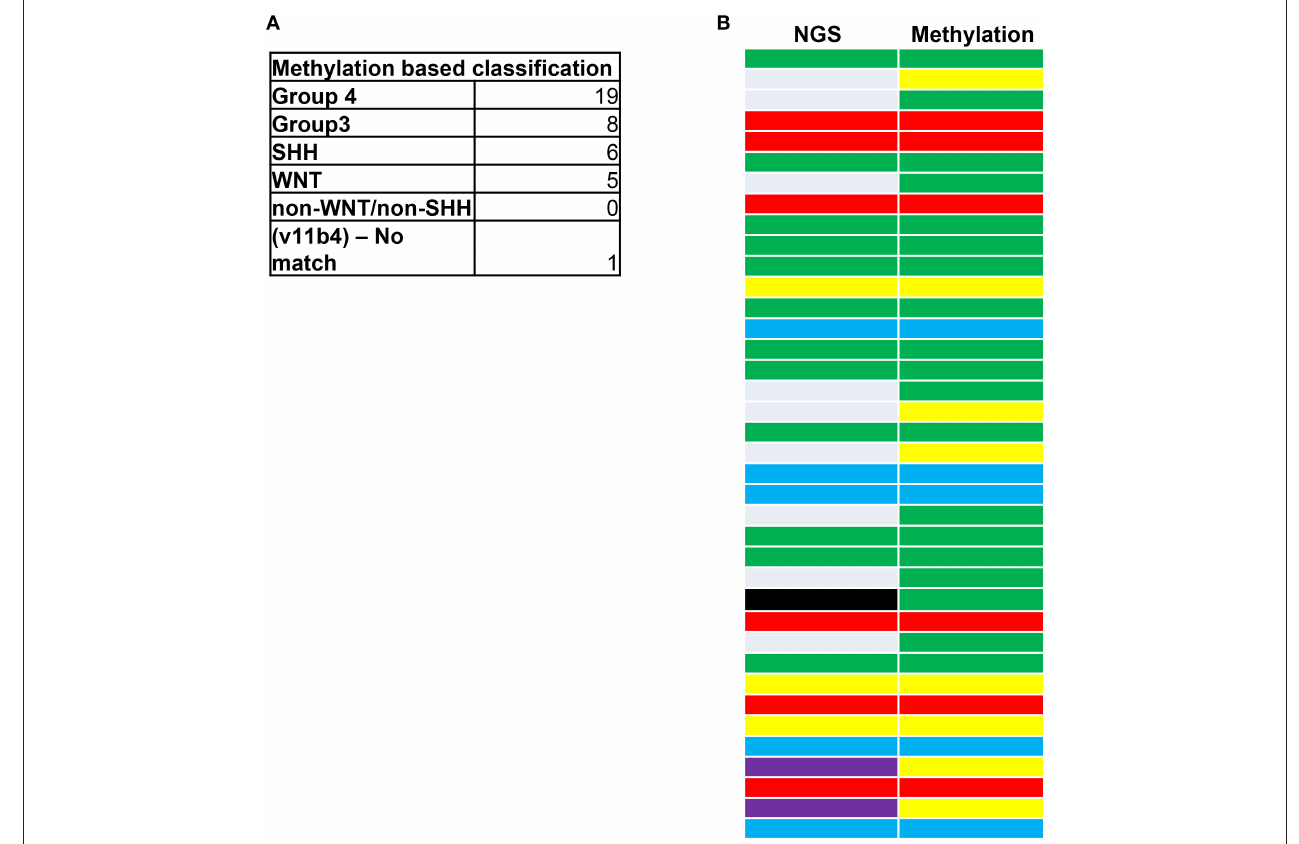
FIGURE 2 | (A) Medulloblastoma next-generation sequencing (NGS) and DNA methylation profiling. (B) Classifications are shown according to the accepted coding for MB tumors: G3 (yellow), G4 (green), SHH (red), WNT (blue), and non-WNT/SHH (gray). A sample not classified by NGS (black) was classed as a G4 tumor through methylation analysis. Purple represents G3/G4 subgrouping by NGS that were subclassed as G3 tumors through methylation profiling. The correlation between NGS and methylation status was 68.42%. A total of eight samples could not be classified for methylation subgrouping due to insufficient sample